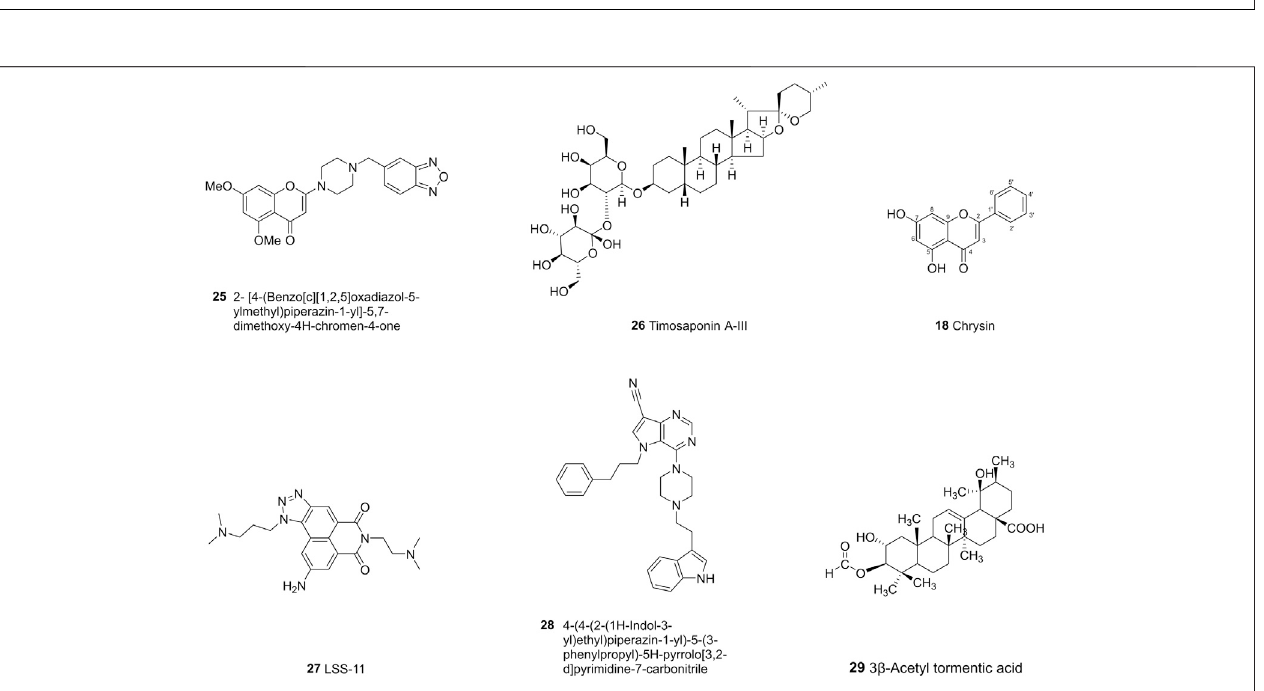
FIGURE 5 | The chemical structures of representative ABCG2 inhibitors.